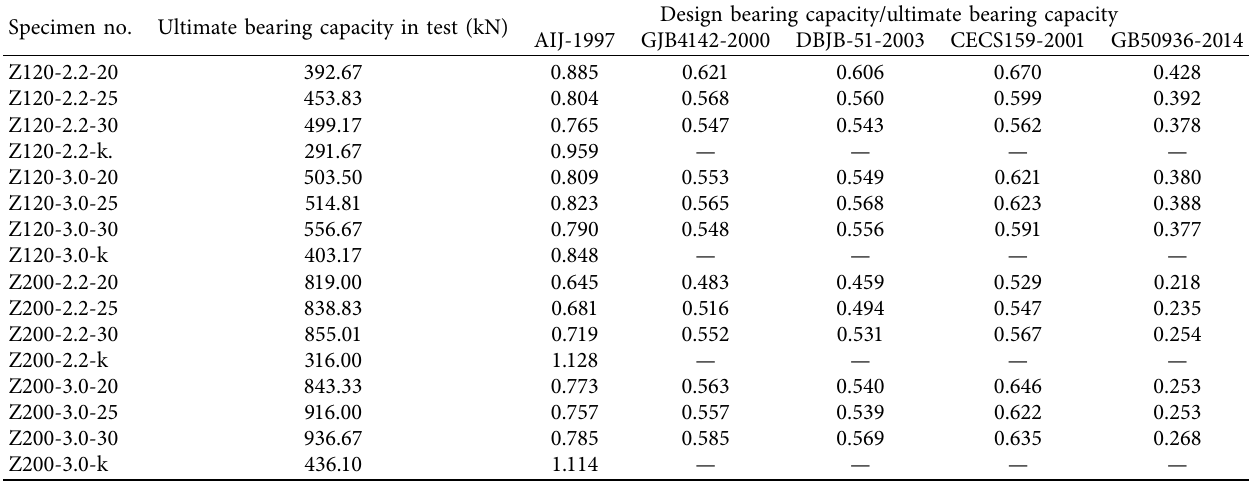
Table 6: Comparison of calculated bearing capacity of codes.